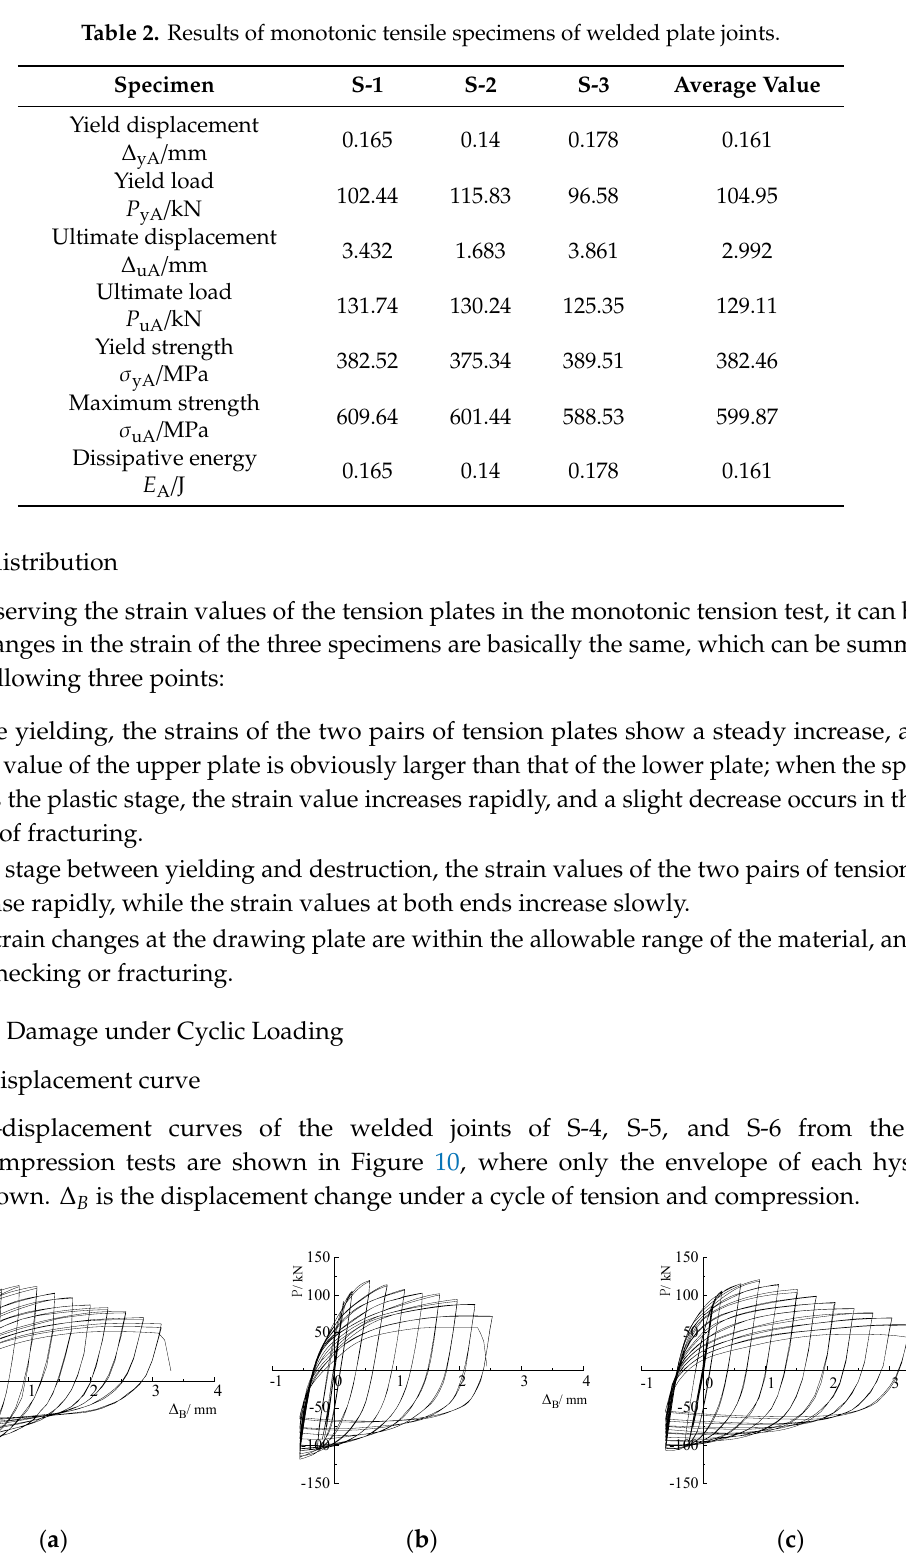
Figure 10. Load–displacement curves: ( a ) S-4; ( b ) S-5; ( c )